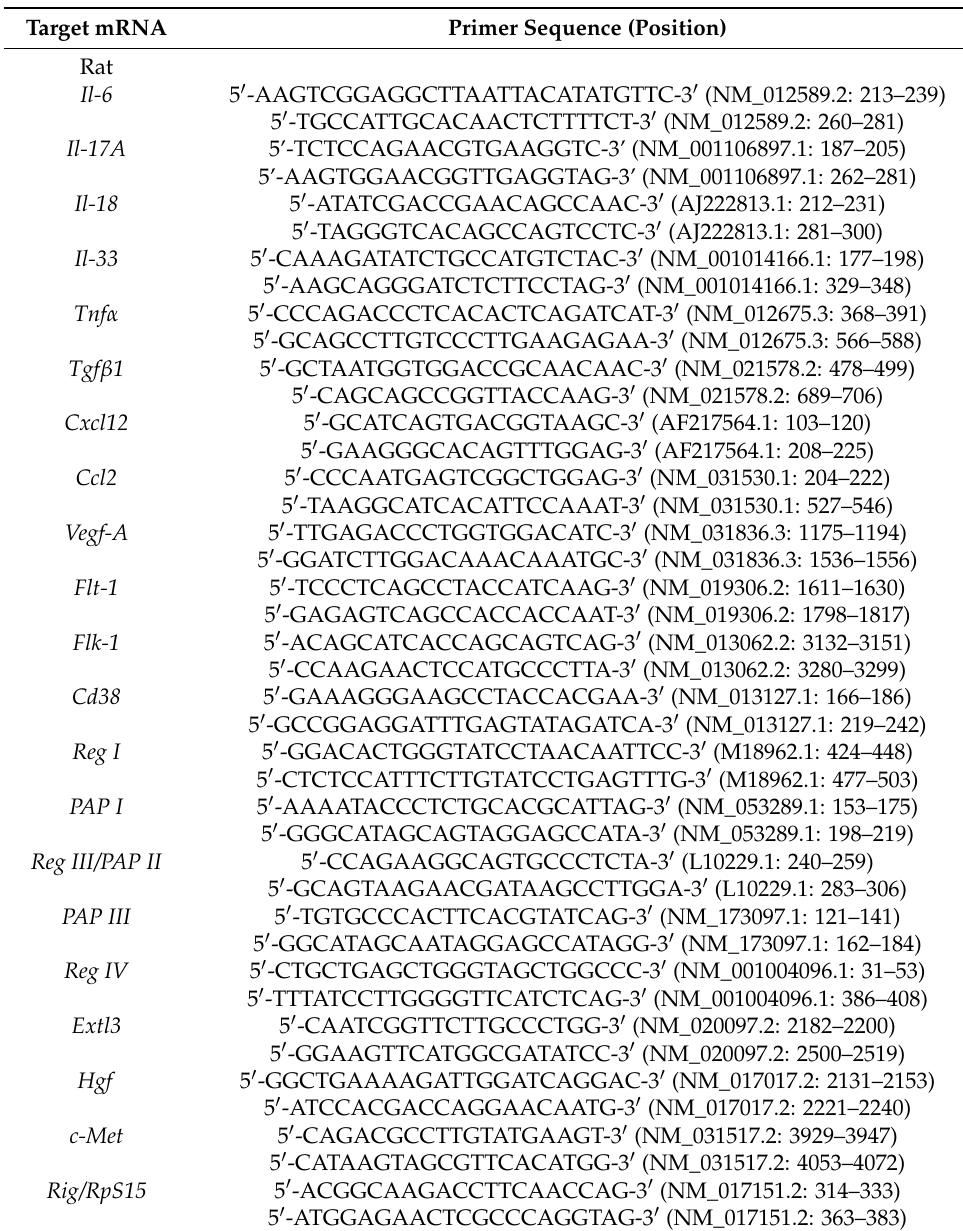
Table 1. PCR primers for real-time